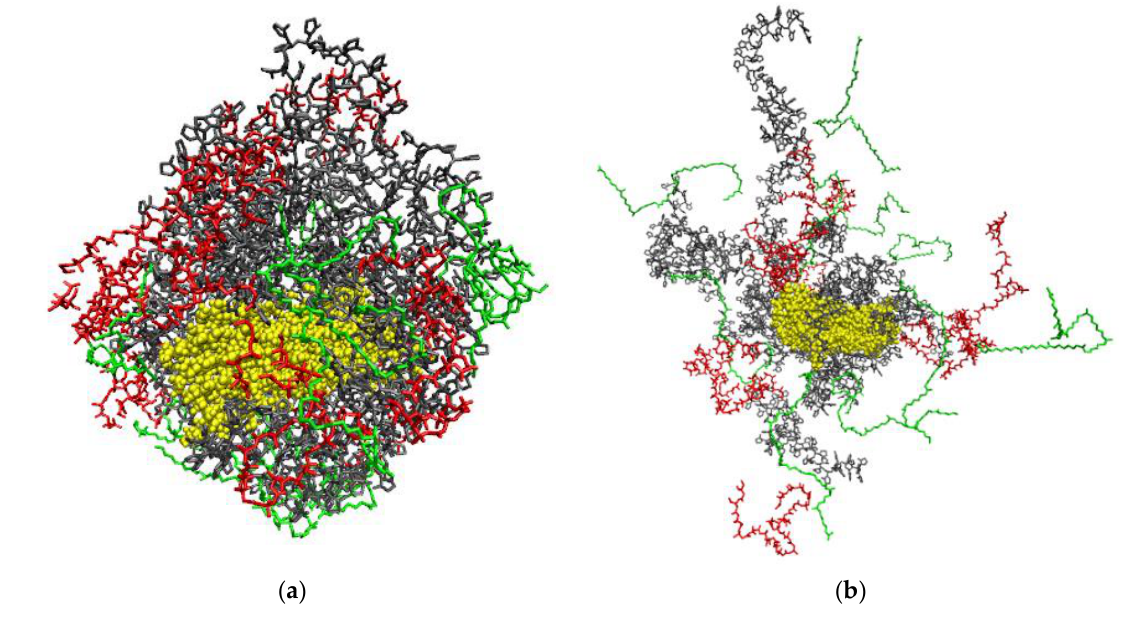
Figure 26. Snapshot of the initial ( a ) and final ( b ) configuration of the PHVB/PCL/PVP/CNC composite in DCM: PVP is colored grey; CNC is colored yellow; PHBV is colored red; PCL is colored green. DCM molecules are not depicted for clarity.